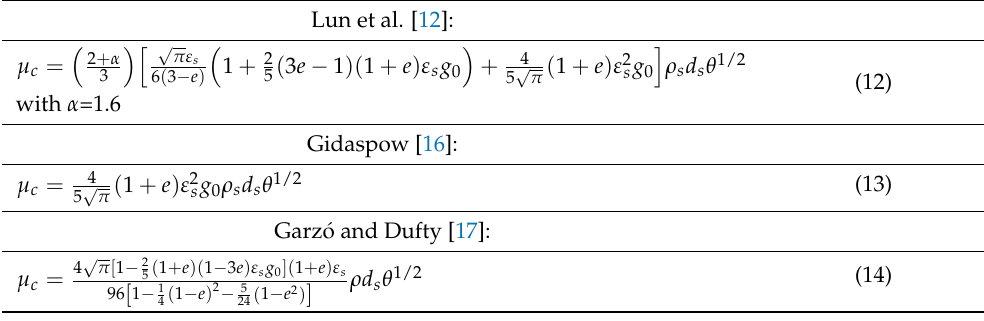
Table 4. Bulk viscosity.